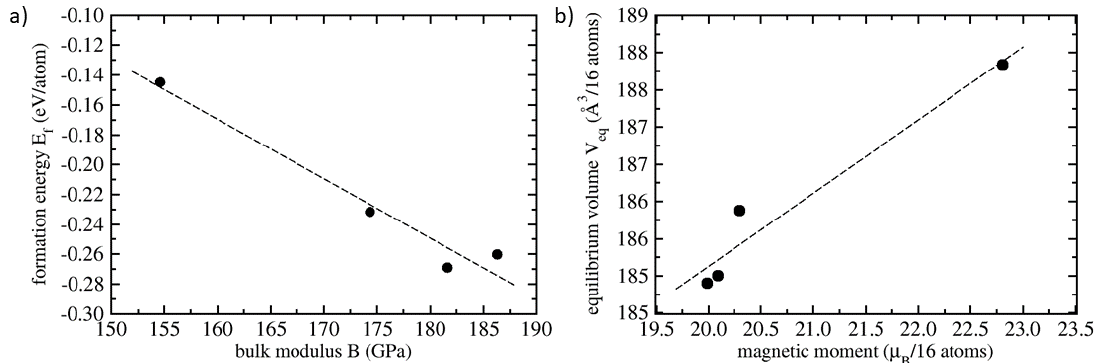
( a ) anti-correlation of the formation energy E f and the bulk modulus B and ( b ) correlation between the equilibrium volume and the magnetic moment of 16-atom supercells visualized in Figure 1. The dashed lines are linear fits obtained by the least-square